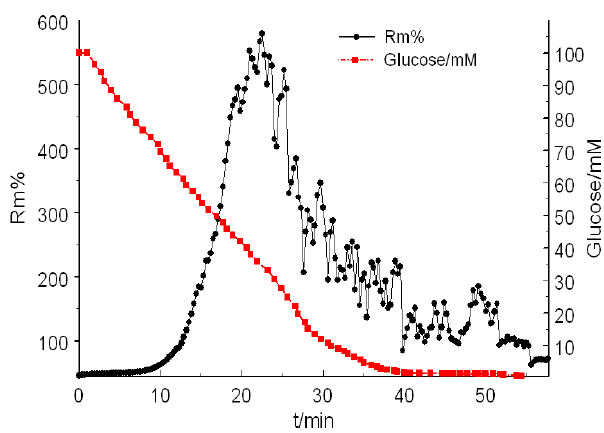
Fig. 9: Plot of the glucose concentration (mM) as a function of